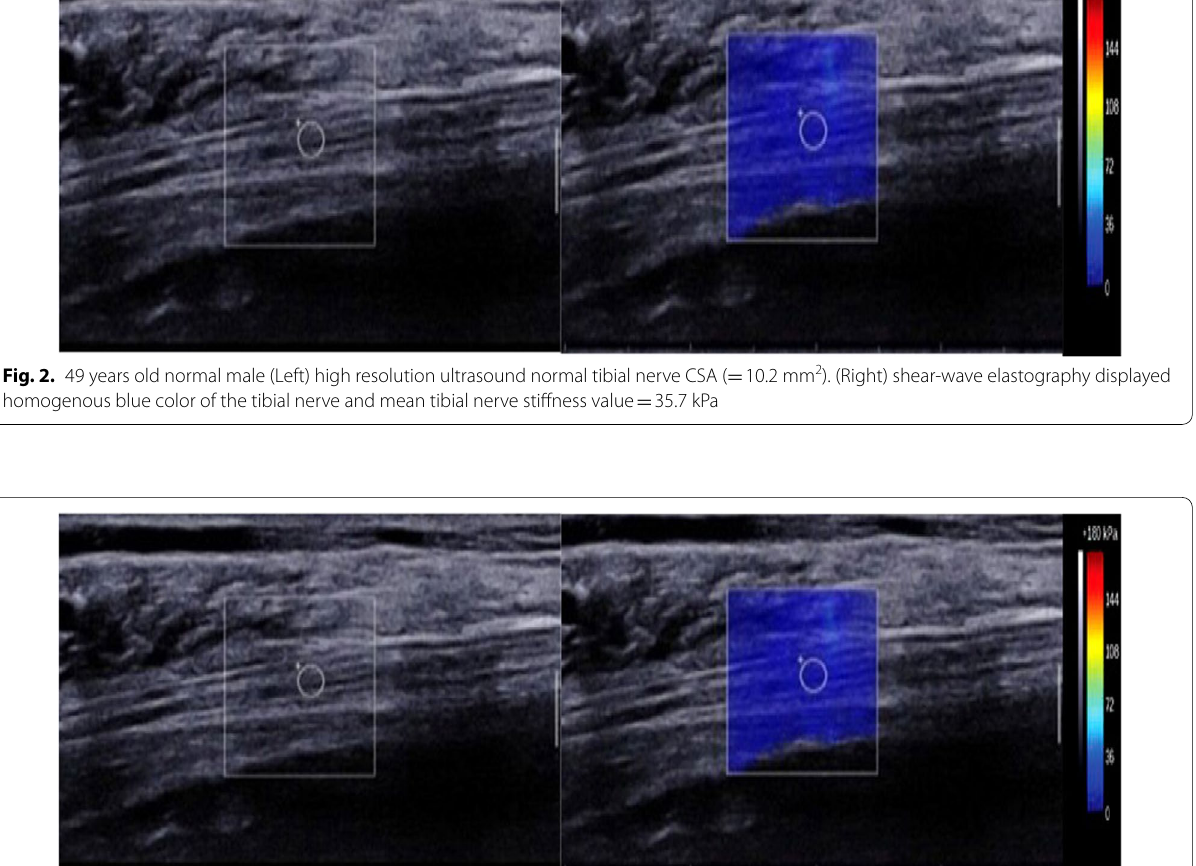
Fig. 3 A 52 years old female patient with DM without clinical evidence of DPN (Left) high resolution ultrasound showed normal tibial nerve CSA ( 11.6 mm 2 ). (Right) shear-wave elastography displayed mean tibial nerve stiffness value =